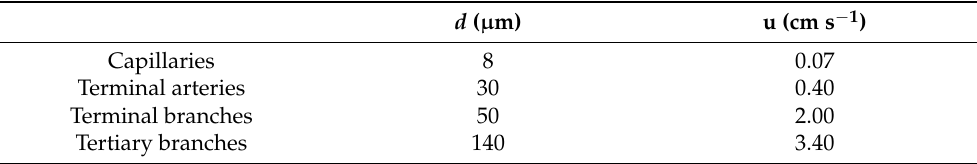
Table 1. The investigated blood vessel diameters and consequent blood flow